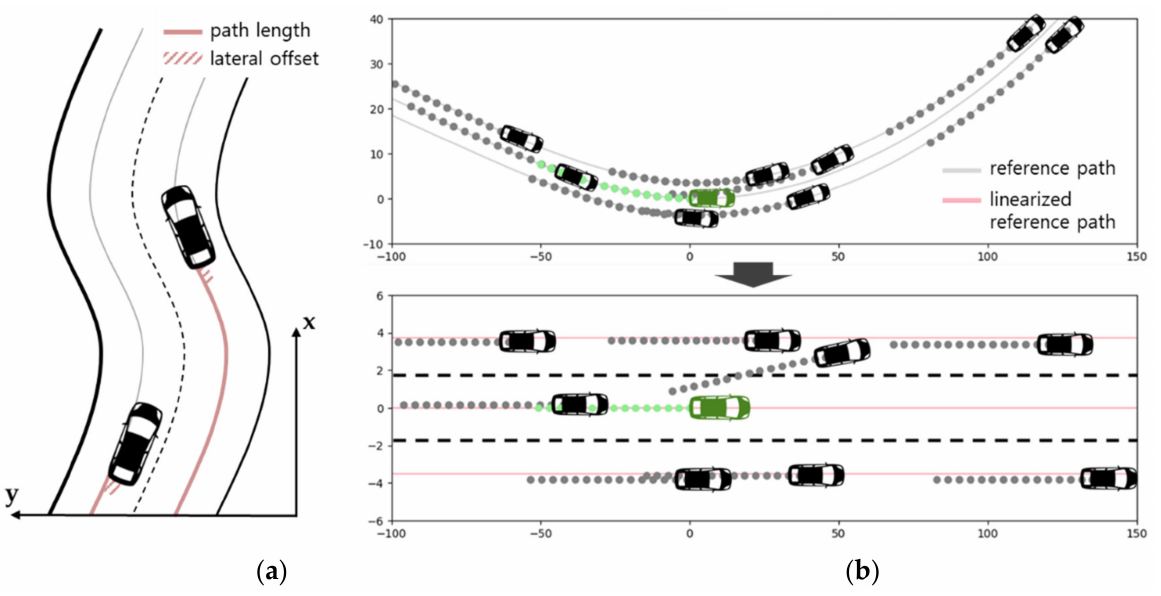
Figure 9. Road geometry linearization method: ( a ) reference of frame and ( b ) path